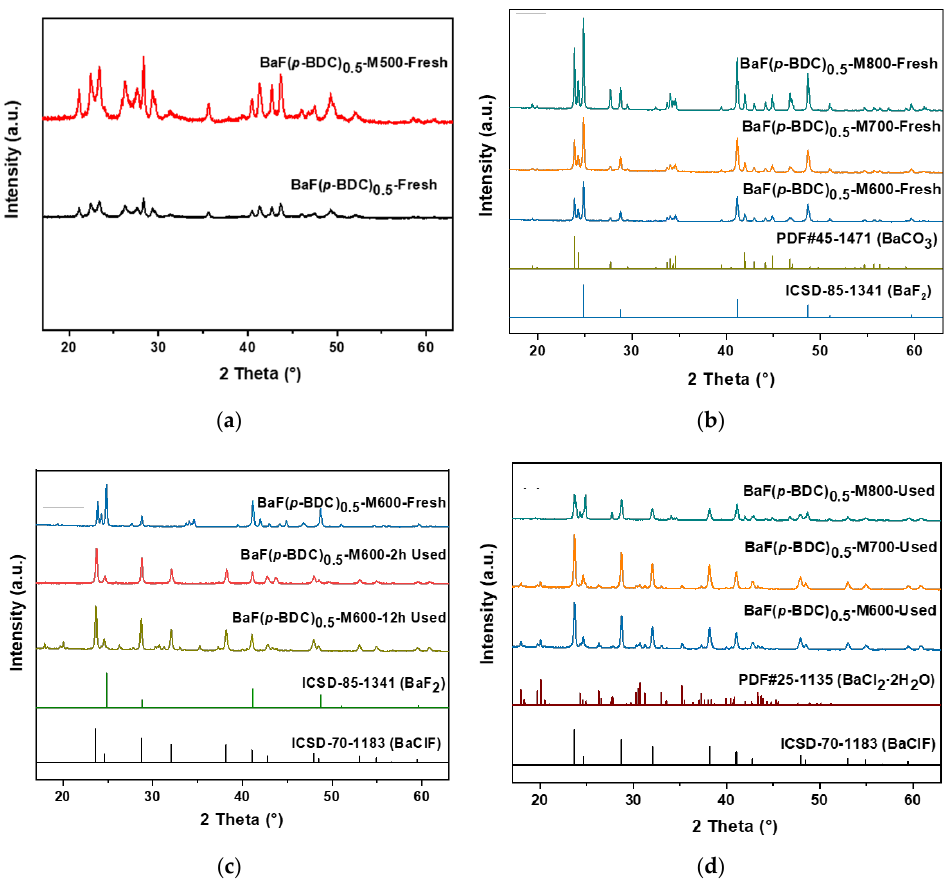
Figure 2. XRD patterns of fresh ( a , b ) and used catalysts ( c , d ), respectively. With BaF( p −BDC) 0.5 −M600, BaF( p −BDC) 0.5 −M700 and BaF( p −BDC) 0.5 −M800 as